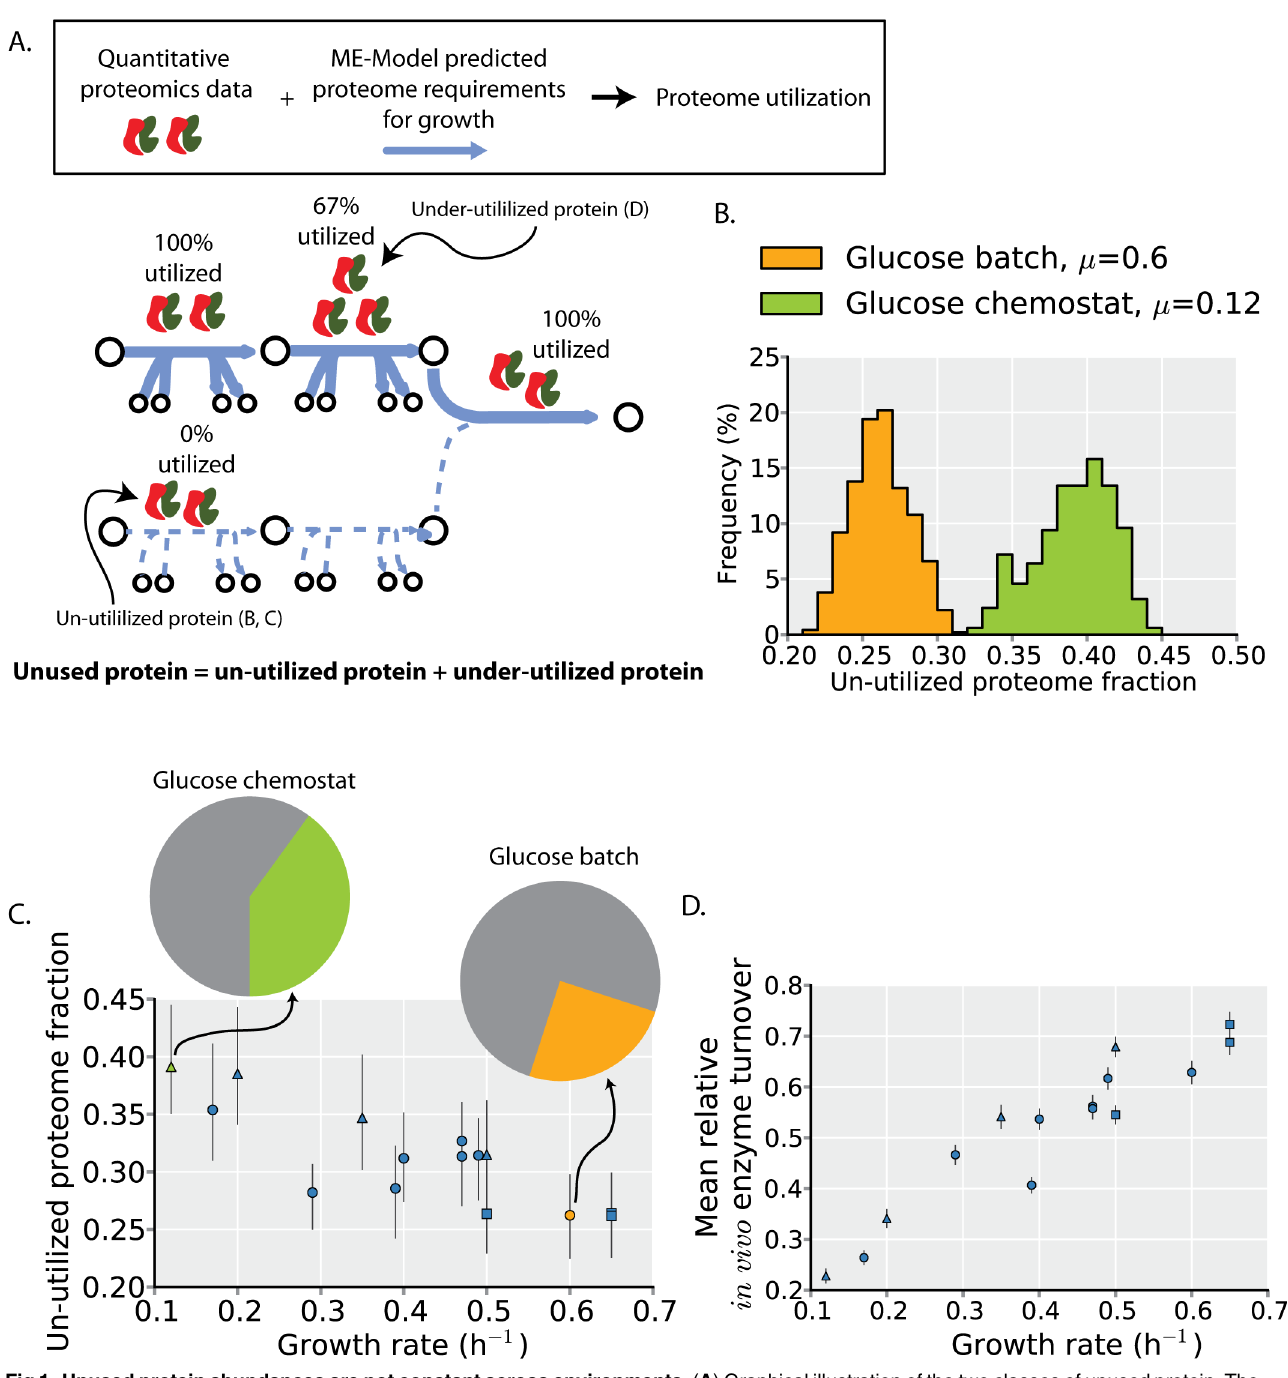
Fig 1. Unused protein abundances are not constant across environments. ( A ) Graphical illustration of the two classes of unused protein. The first class is protein that is expressed but completely un-utilized (i.e., 0% utilized) first step in lower pathway). The second class is protein that is under-utilized (i.e., < 100% but > 0% utilized; second step in upper pathway, see Methods). The percent utilization indicated is based on the upper pathway having flux of 2, the lower pathway having flux of 0, and all enzymes having a maximal rate of 1 (see also S1 Fig). ( B ) The un-utilized proteome fractions for batch and chemostat culture on glucose minimal media. The un-utilized proteome fraction is a distribution rather than a specific value because of different potential alternative pathways and enzymes that can be used to support cellular growth (see main text). ( C ) The un-utilized proteome fraction across all profiled environments — 8 different carbon source batch cultures (circles), 4 glucose-limited chemostat cultures (triangles), and 4 stress conditions (squares) — is plotted as a function of the growth rate measured in that condition. Error bars indicate 2.5 and 97.5 percentiles of the un-utilized proteome distributions for each condition (e.g. Fig 1B). The orange and green points and pie charts correspond to the